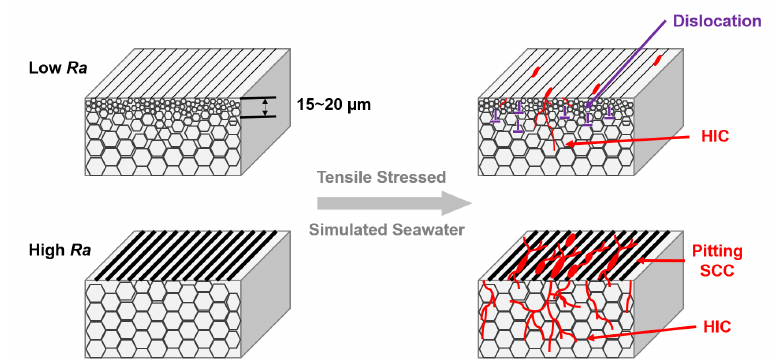
Figure 12. Model illustrating the impact of machining-induced grain refinement and surface roughness variation on SCC susceptibility of